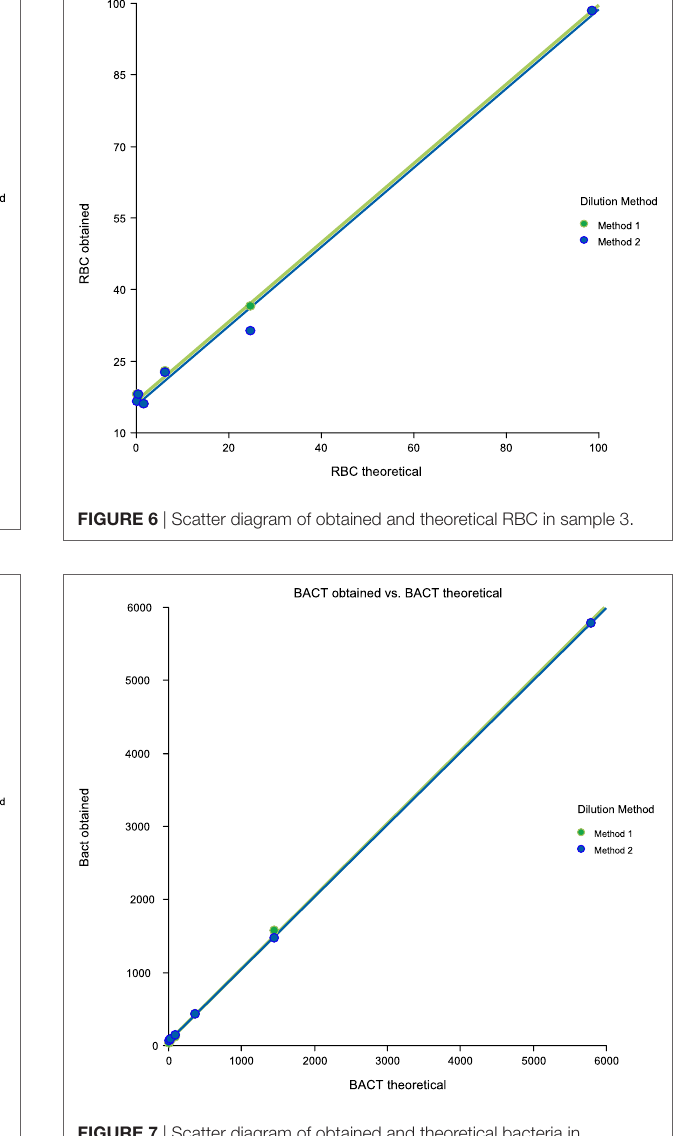
FIgURe 5 | Scatter diagram of obtained and theoretical RBC in sample 2.